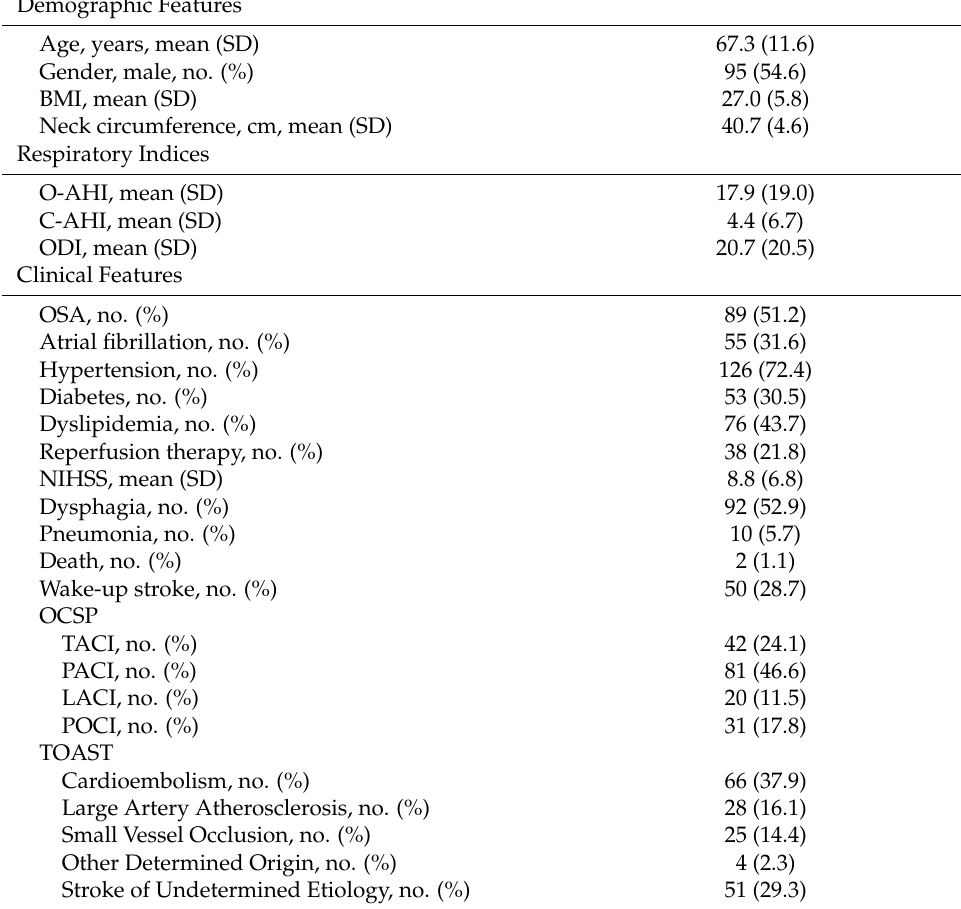
Table 1. Demographic features, respiratory indices, and clinical features of the study population.